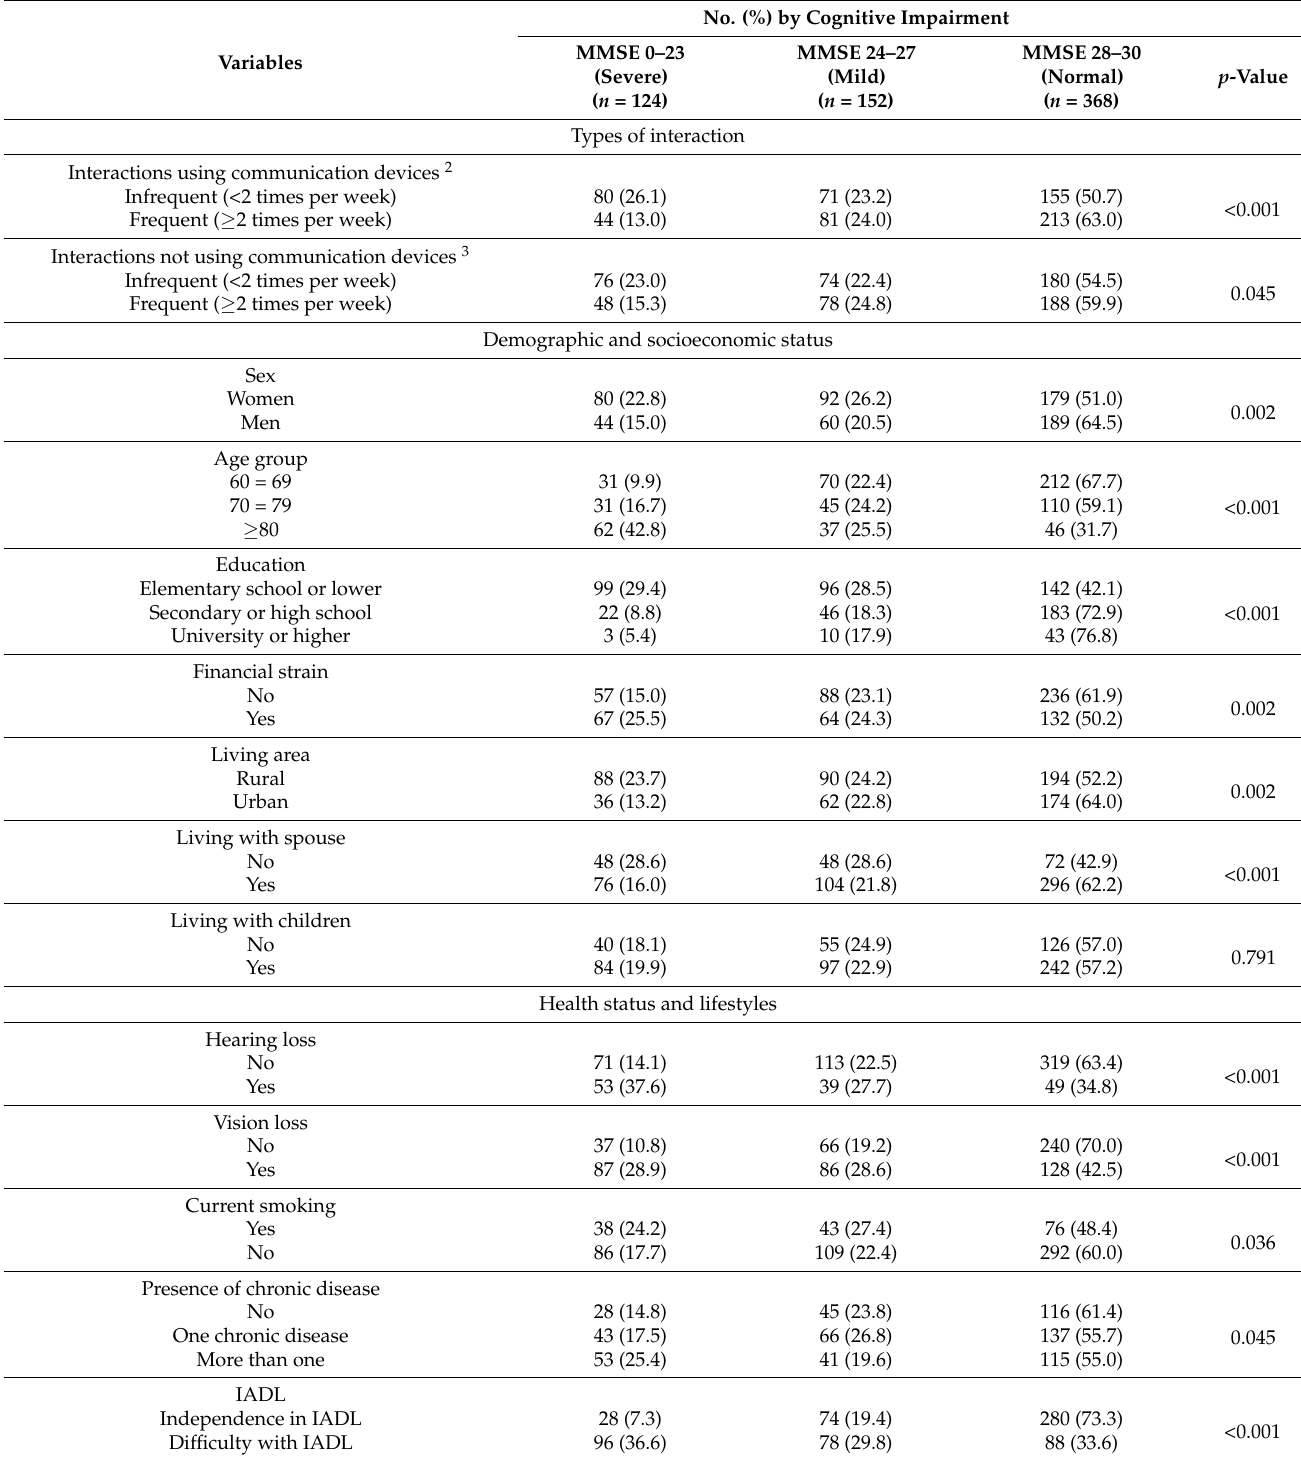
Table 2. Cognitive function levels according to types of interactions and the characteristics of participants 1